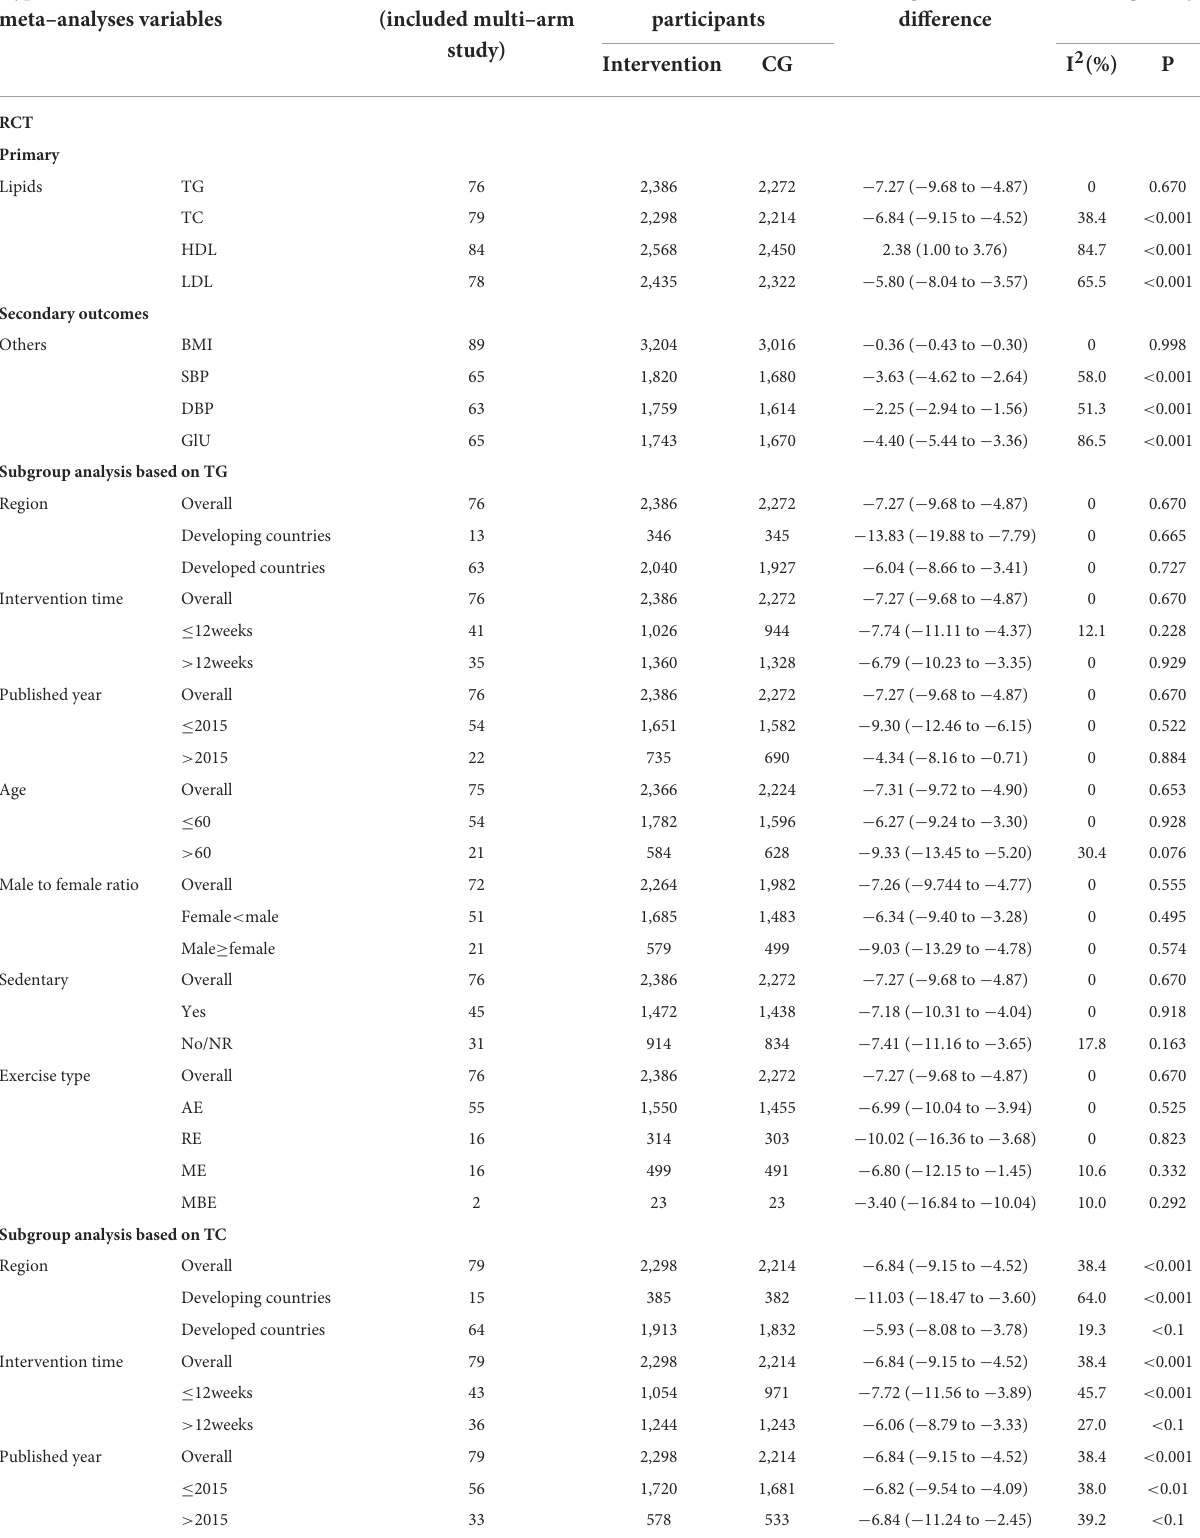
TABLE 1 Outcomes and subgroup analysis based on indicators related to